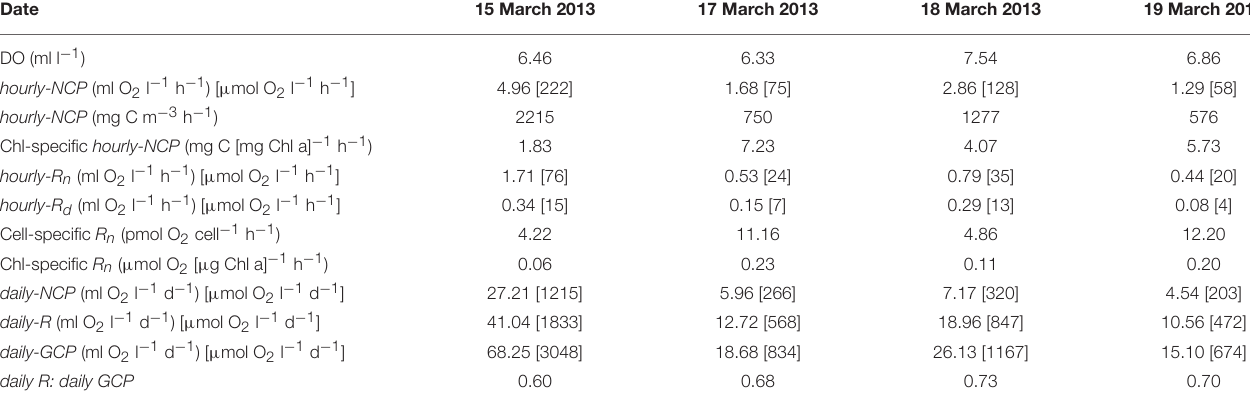
TABLE 3 | Date of surface water collection, DO concentrations prior to incubation, hourly estimates of net community production ( hourly-NCP ), including estimates expressed in terms of carbon and normalized to Chl- a , hourly estimates of community respiration ( hourly-R n ) as determined in the light carboy, hourly estimates of community respiration as determined in the dark carboy ( hourly-R d ), cell, and Chl- a specific values of hourly-R n , daily estimates of net community production ( daily-NCP ) as determined from the increment in DO concentration in the light bottle over 24h, daily estimates of respiration ( daily-R = hourly-R n × 24; respiration during the day was assumed to be equal to respiration during the night), daily estimates of gross community production ( daily-GCP = daily-NCP + daily-R ), and the ratio of daily-R : daily-GCP